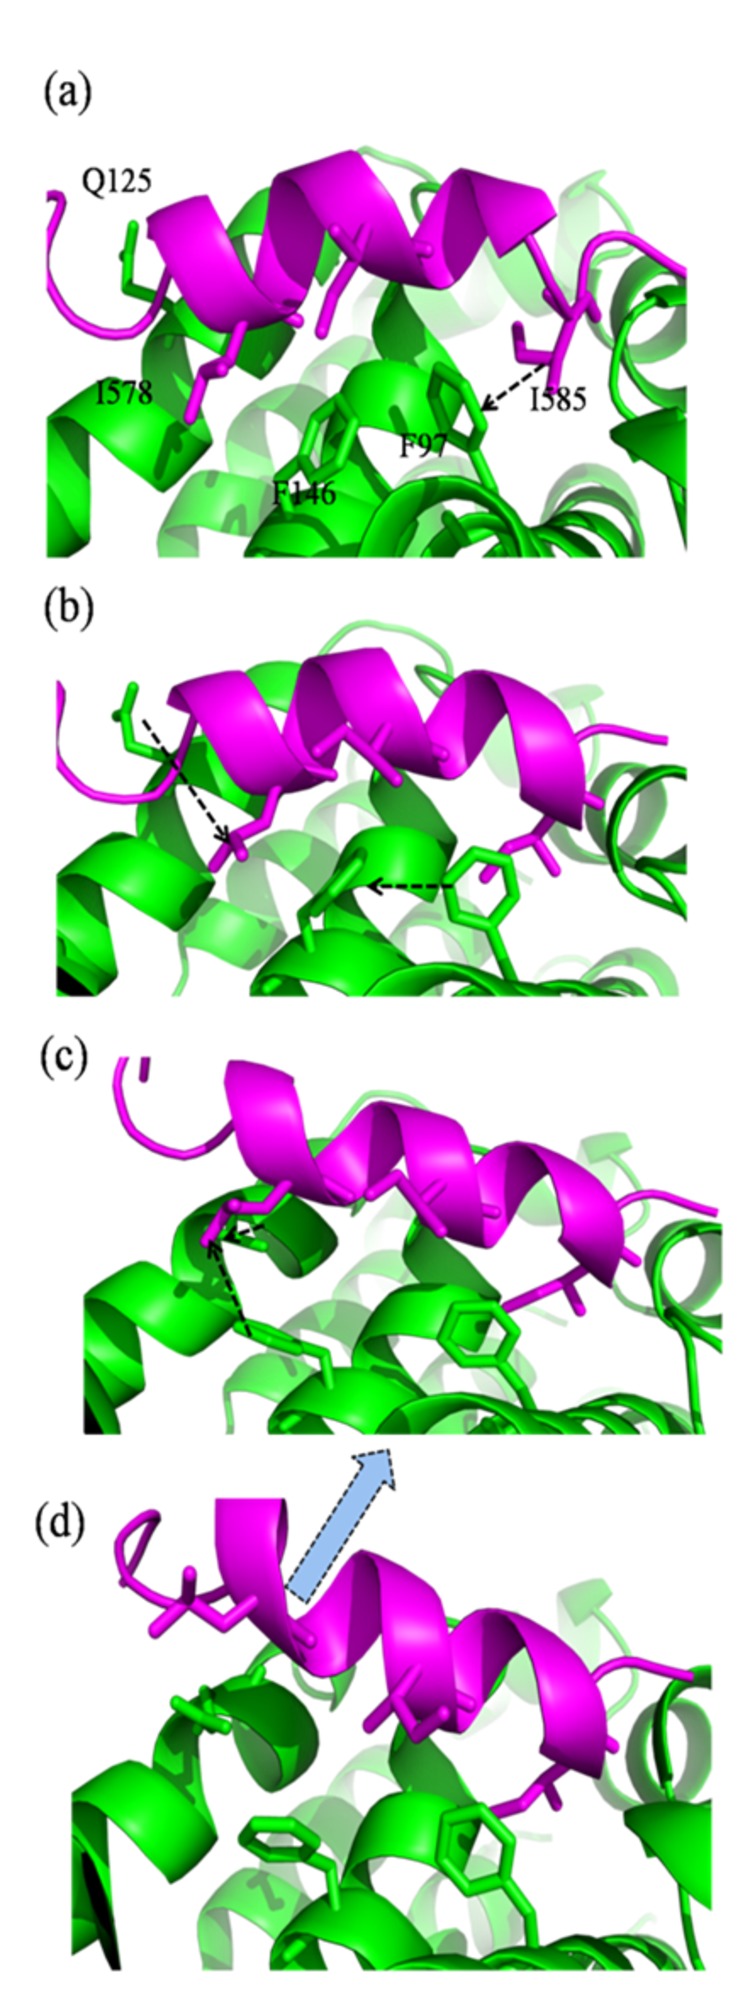
Concerted collisions kicking out of ligand from Bcl-xl-BH3Bak complex in membrane.